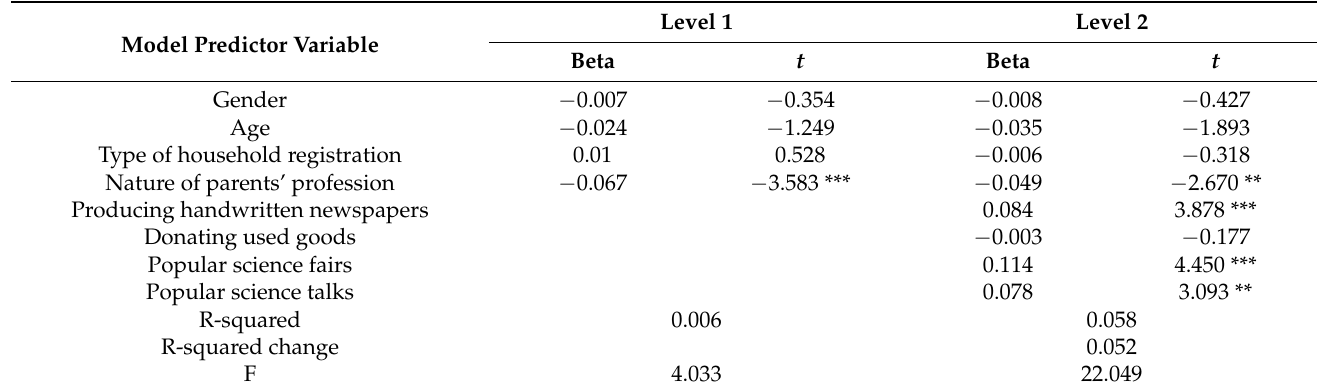
Table A4. Regression analysis of the effects of four types of climate change knowledge on willingness to participate in carbon neutrality